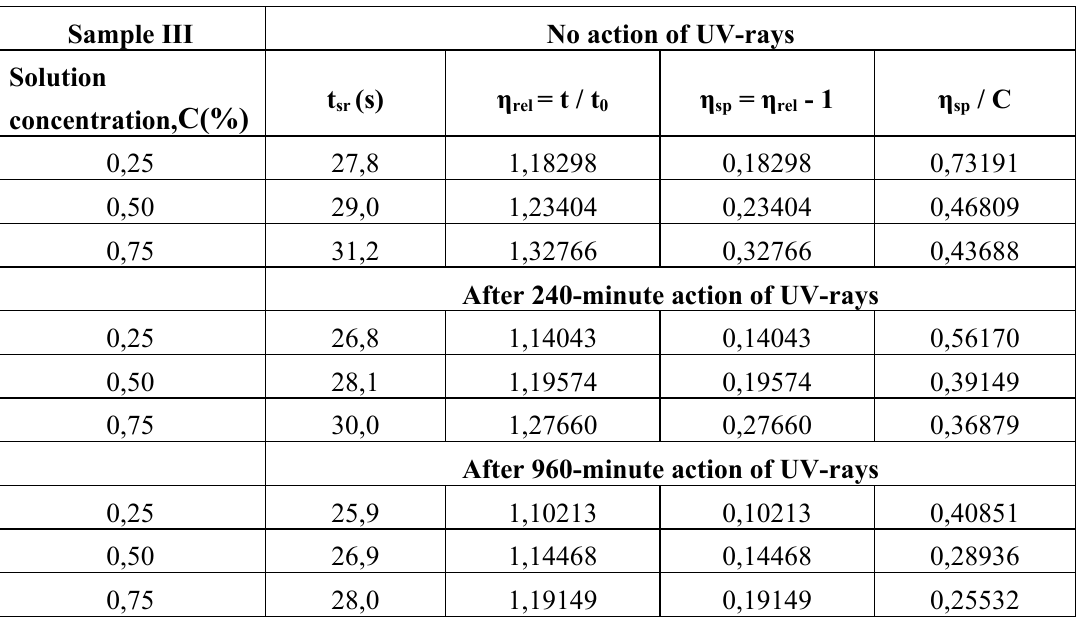
Table 6. Viscosity values of nitrodope solution in acetone for sample III Sample III